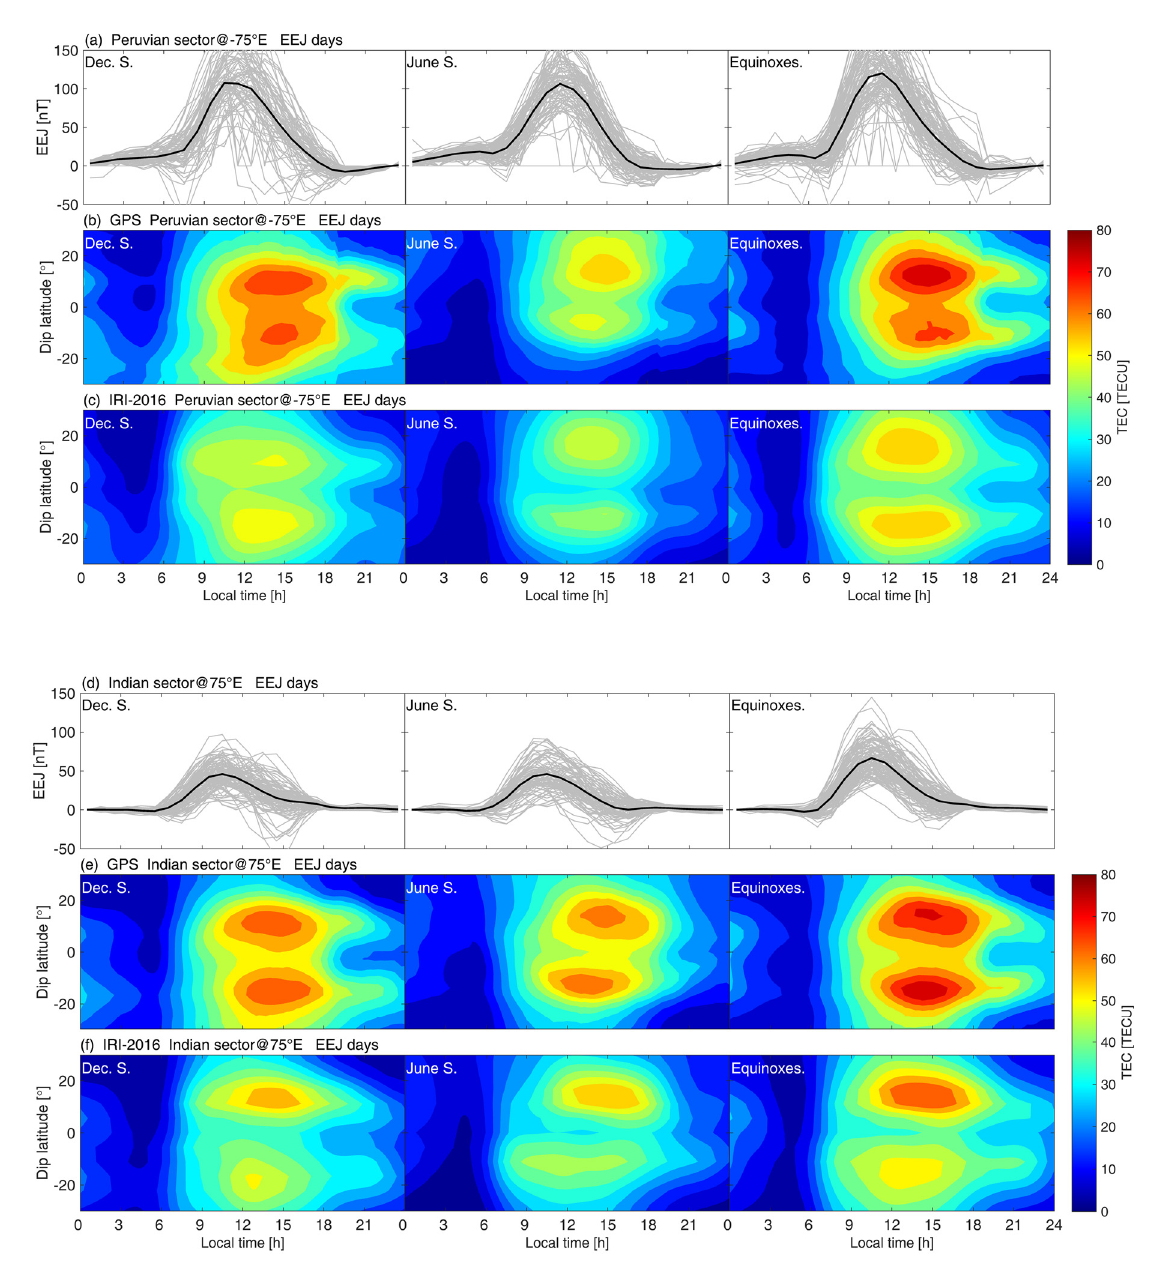
Figure 3. Seasonal averaged TEC maps over the Peruvian and Indian sectors during EEJ days when the averaged EEJ intensity at 0800–1200 UT was relatively high during three seasons of December Solstice (left column), June Solstice (middle column) and equinoxes (right column). ( a ) EEJ profiles of Peruvian sector; ( b ) GPS TEC at Peruvian sector; ( c ) IRI-2016 derived TEC at Peruvian sector; ( d – f ) are organized in a same format as ( a – c ) but for the Indian sector.